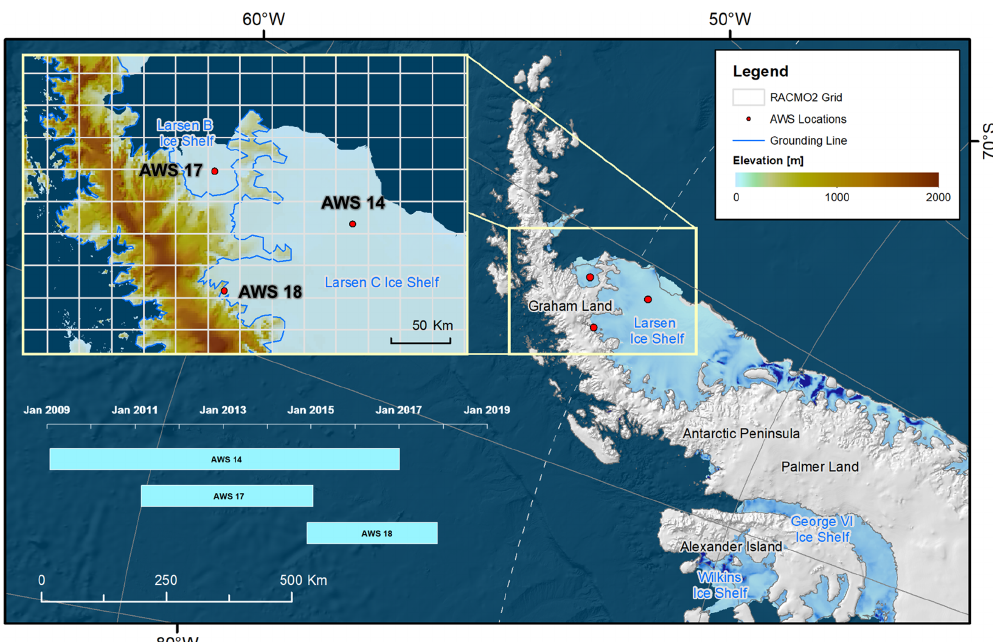
Figure 1. Overview of the study area, the Larsen Ice Shelf, and details about the geolocations and operation periods of the deployed automatic weather station (AWS) observations. Surface elevation is derived from the ETOPO1 1 Arc-Minute Global Relief Model (https://www.ncei.noaa.gov/access/metadata/landing-page/bin/iso?id=gov.noaa.ngdc.mgg.dem:316, last access: 3 December 2021), and the grounding line information is derived from Bindschadler et al. (2011). The base maps are the Moderate Resolution Imaging Spectroradiome- ter (MODIS) Image Mosaic and the Antarctic ice-shelf buttressing (Fürst et al.,